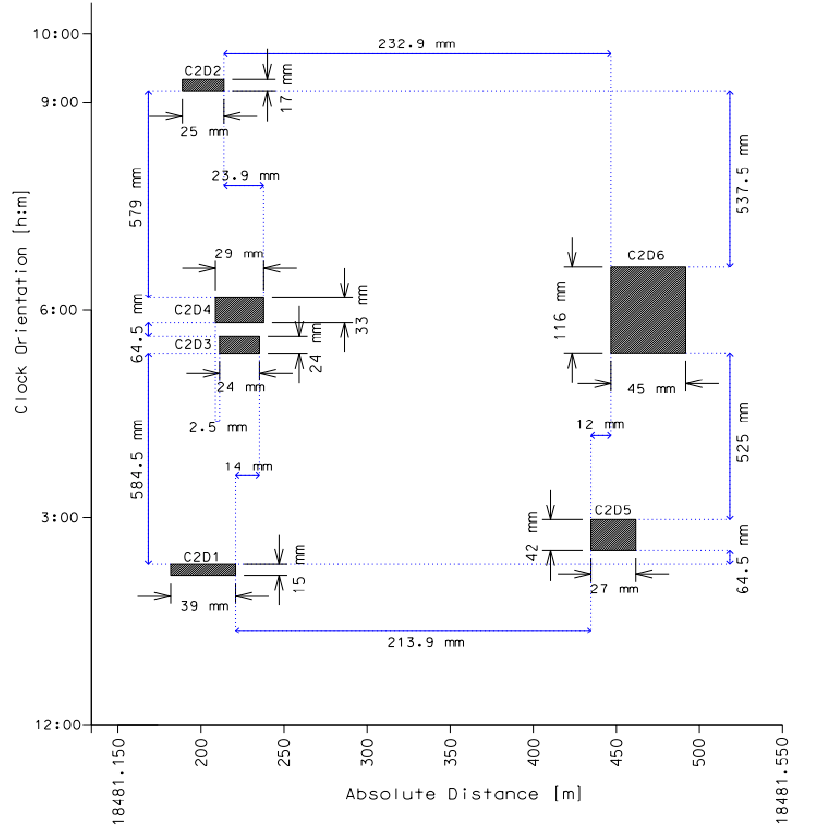
Figure 4. Graphical presentation of metal losses spacing in group 2. Source: Author’s analysis. Table 2. Metal loss sizing in group 2. Source: Author’s analysis.